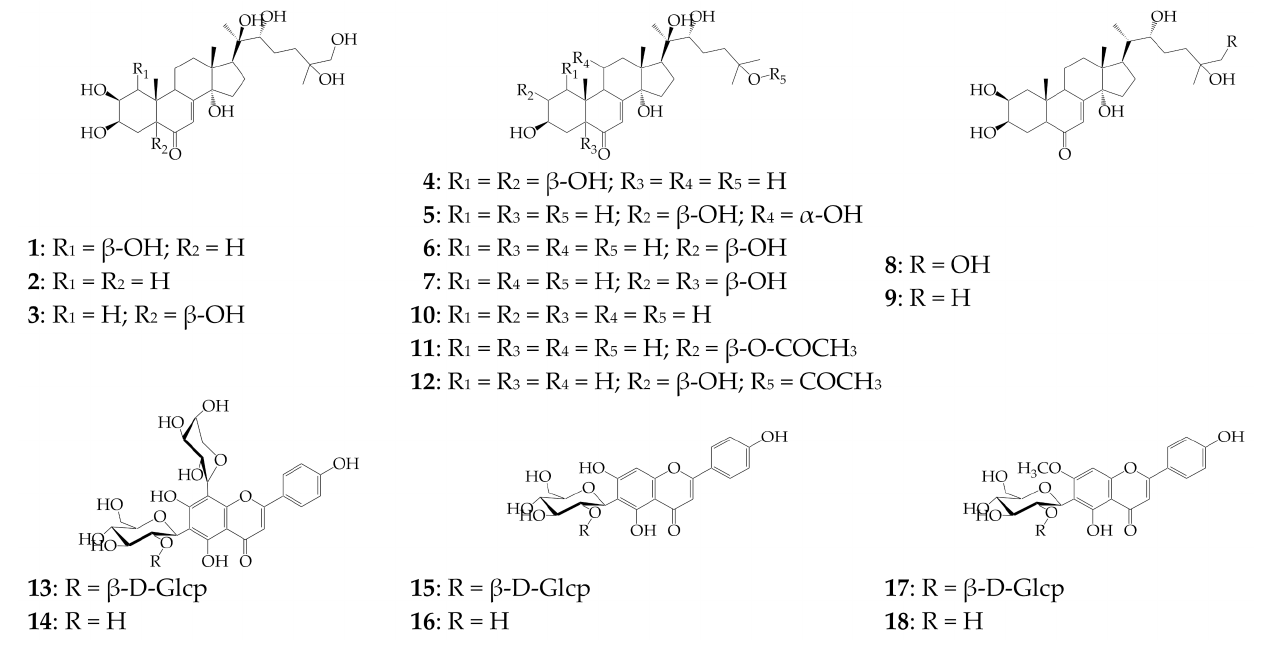
Figure 2. Structures of compounds 1 – 18 found in S. repens . Abbreviation used: β -D-Glc p — β -D-Glucopyranose.